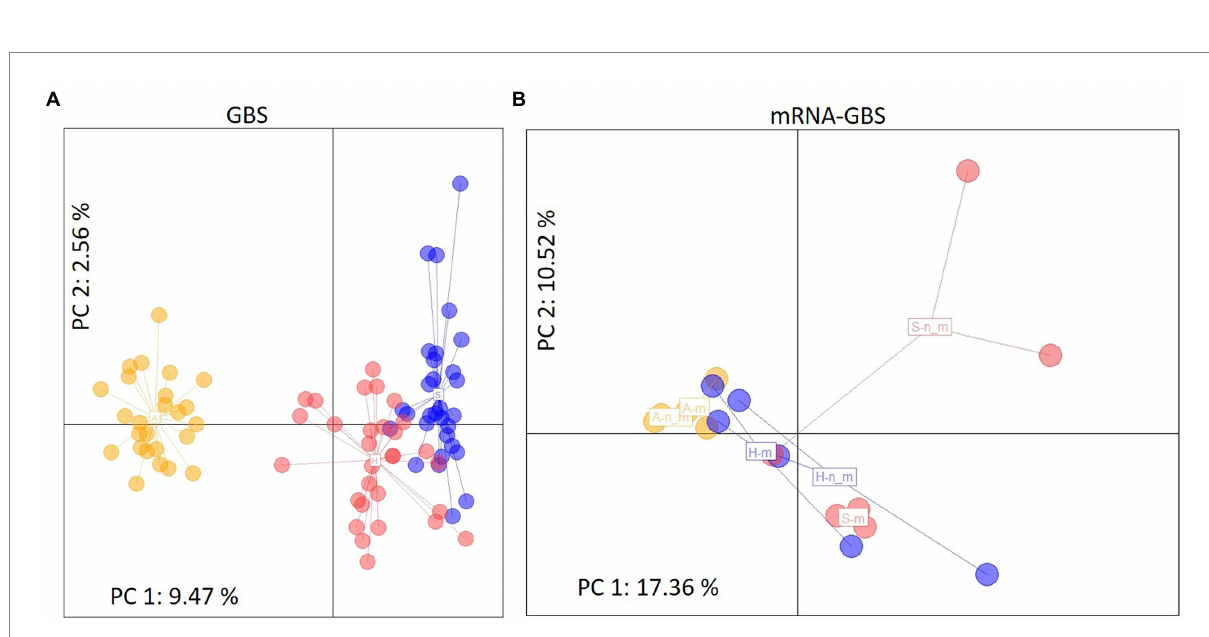
FIGURE 5 Principal Component Analysis (PCA) of genetic distances between individuals (GBS) or site specific bulk samples (mRNA-GBS) of Trifolium pratense across the different Biodiversity Exploratories (S, Schorfheide-Chorin; H, Hainich-Dün; A, Swabian Alb). Colored label positions represent the centroids of all individuals belonging to one sampling region for (A) The GBS analysis, depicting color coded individuals within each region, where the third axis is representing 2.47% of genetic variation ( Σ 14.50%) and (B) the mRNA-GBS analysis, depicting color coded populations of bulk samples within each region (S, H, A where n_m is not mown, m is mown). The third axis is representing 8.72% genetic variation ( Σ 36.60%).